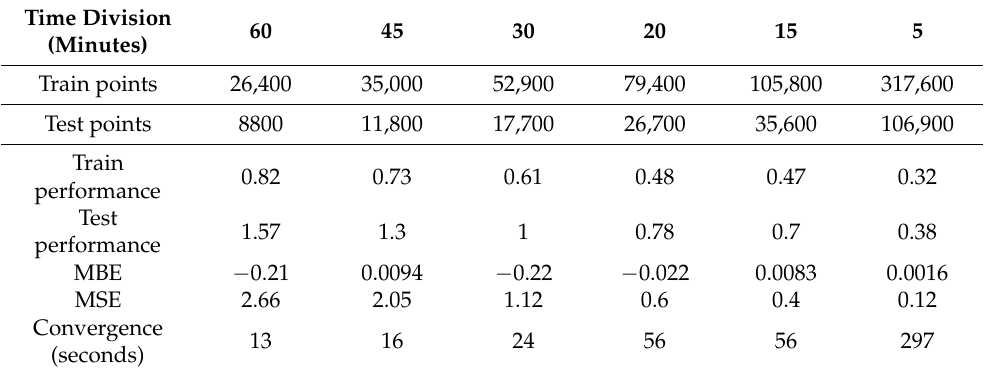
Table 6. The impact of the time division variation.